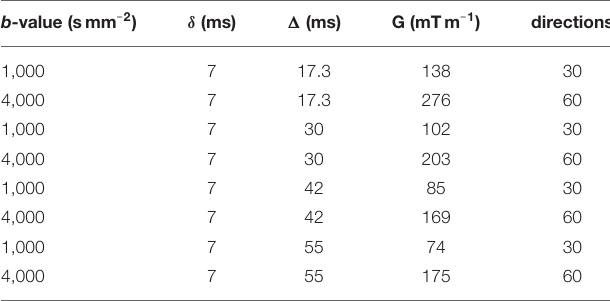
TABLE 1 | DW-MRI acquisition protocol